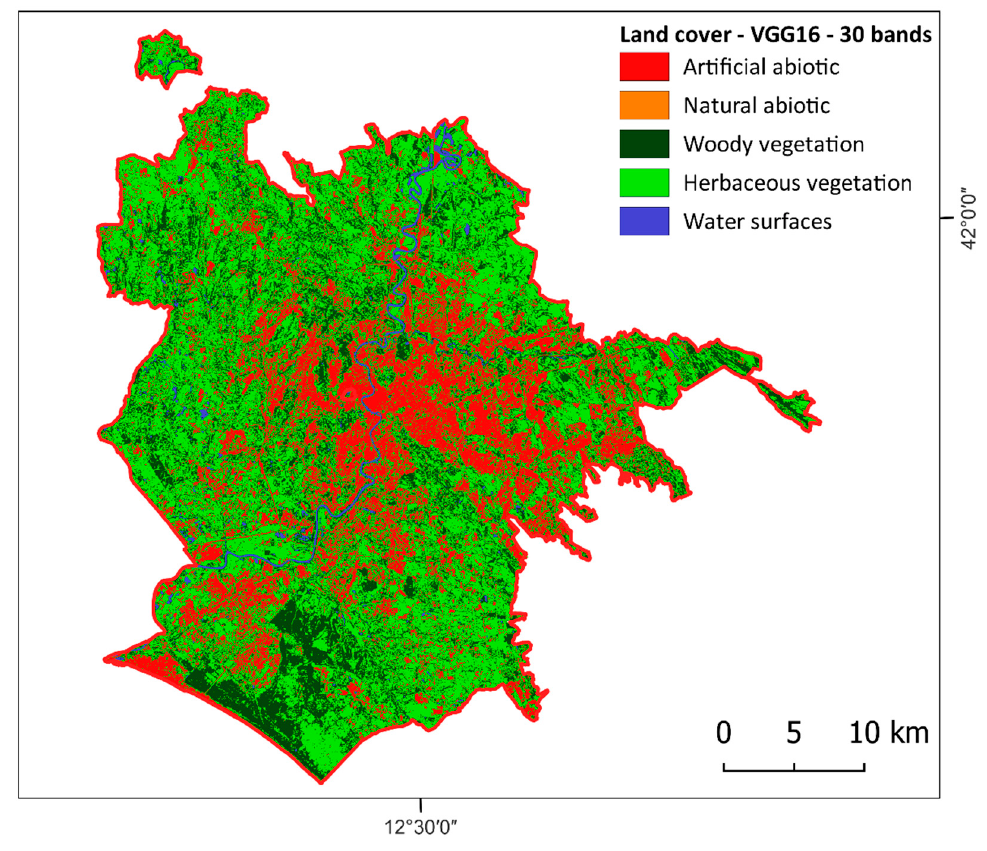
Figure 7. Multi-temporal land cover map of Rome (LCR) produced by classifying the 30-band multi-temporal Sentinel-2 data with the VGG16 algorithm.